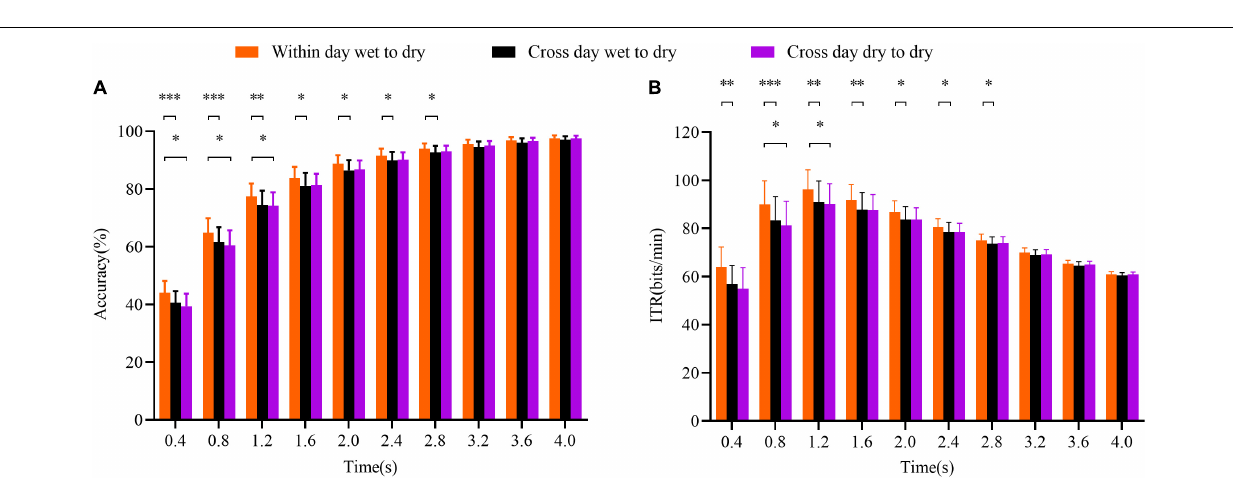
FIGURE 6 | Performance comparison of the ALPHA method for different transfer types. (A) Accuracy. (B) ITR value. The cross-day transfer corresponds to the time dimension, while the wet-to-dry and dry-to-dry transfers correspond to the electrode dimension. The error bars indicate standard errors. The asterisks indicate a difference in the paired t -test results ( ∗ p < 0 . 05, ∗∗ p < 0 . 01, and ∗∗∗ p < 0 .